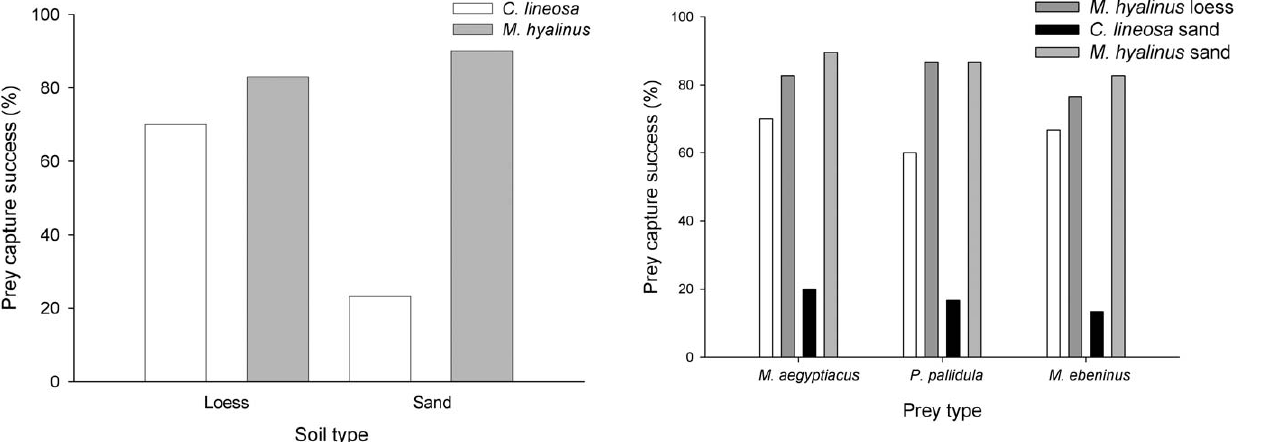
Figure 5. Prey capture success of antlions in the foraging behavior experiment. Prey capture success of M. hyalinus varied little between soils, but that of C. lineosa was markedly reduced when put in the sand. Notably, the prey capture success of the habitat generalist M. hyalinus was higher than that of the habitat specialist C. lineosa in both soil types.